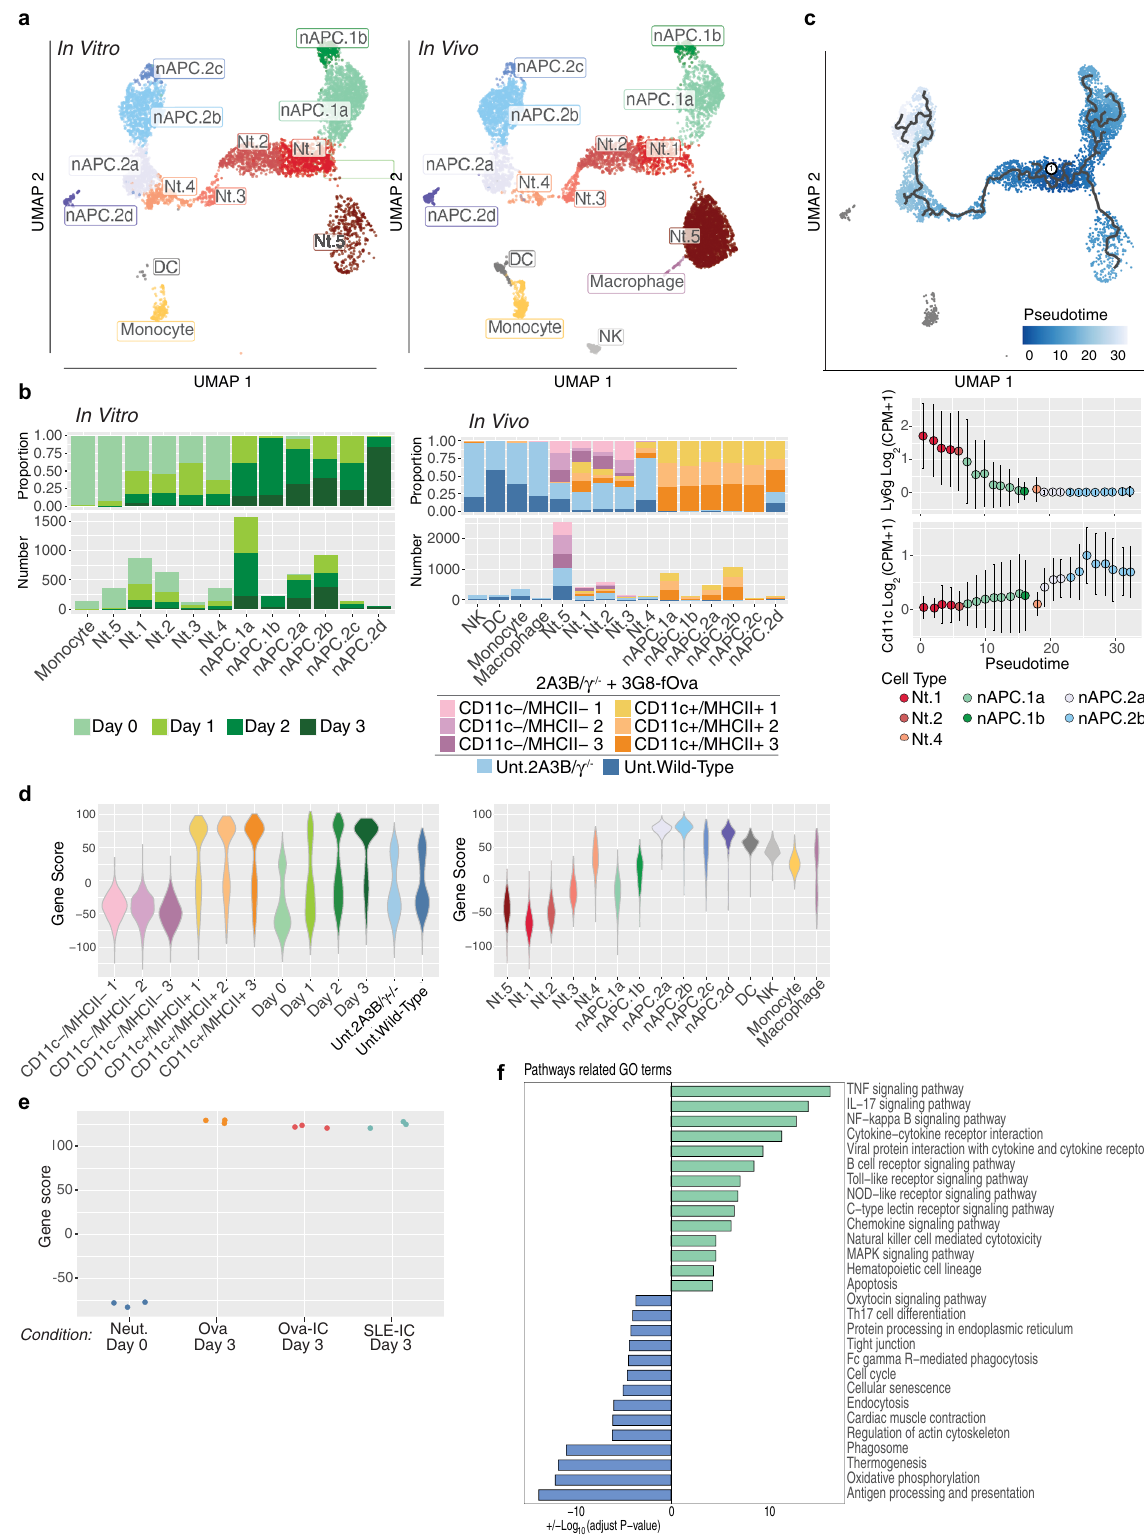
required for diverse processes from migration to cell fate 88 . Endocytosis was also required for IC-induced nAPC generation suggesting that the 3G8-fOva conjugate and ICs engage a similar proximal signaling pathway for nAPC generation. Antigen endocytosis that occurs in parallel with Fc γ RIIIB